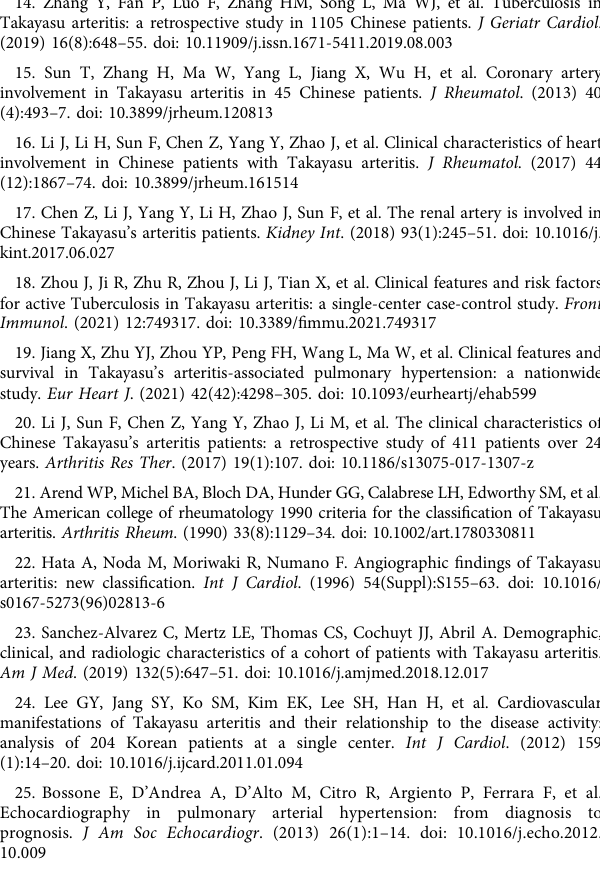
SUPPLEMENTARY FIGURE S1 Distribution of age at onset by sexes in Chinese TAK patients. This fi gure shows the distribution of age at onset for male and female TAK patients in our study. The red bars indicate the female group and the blue ones represent the male